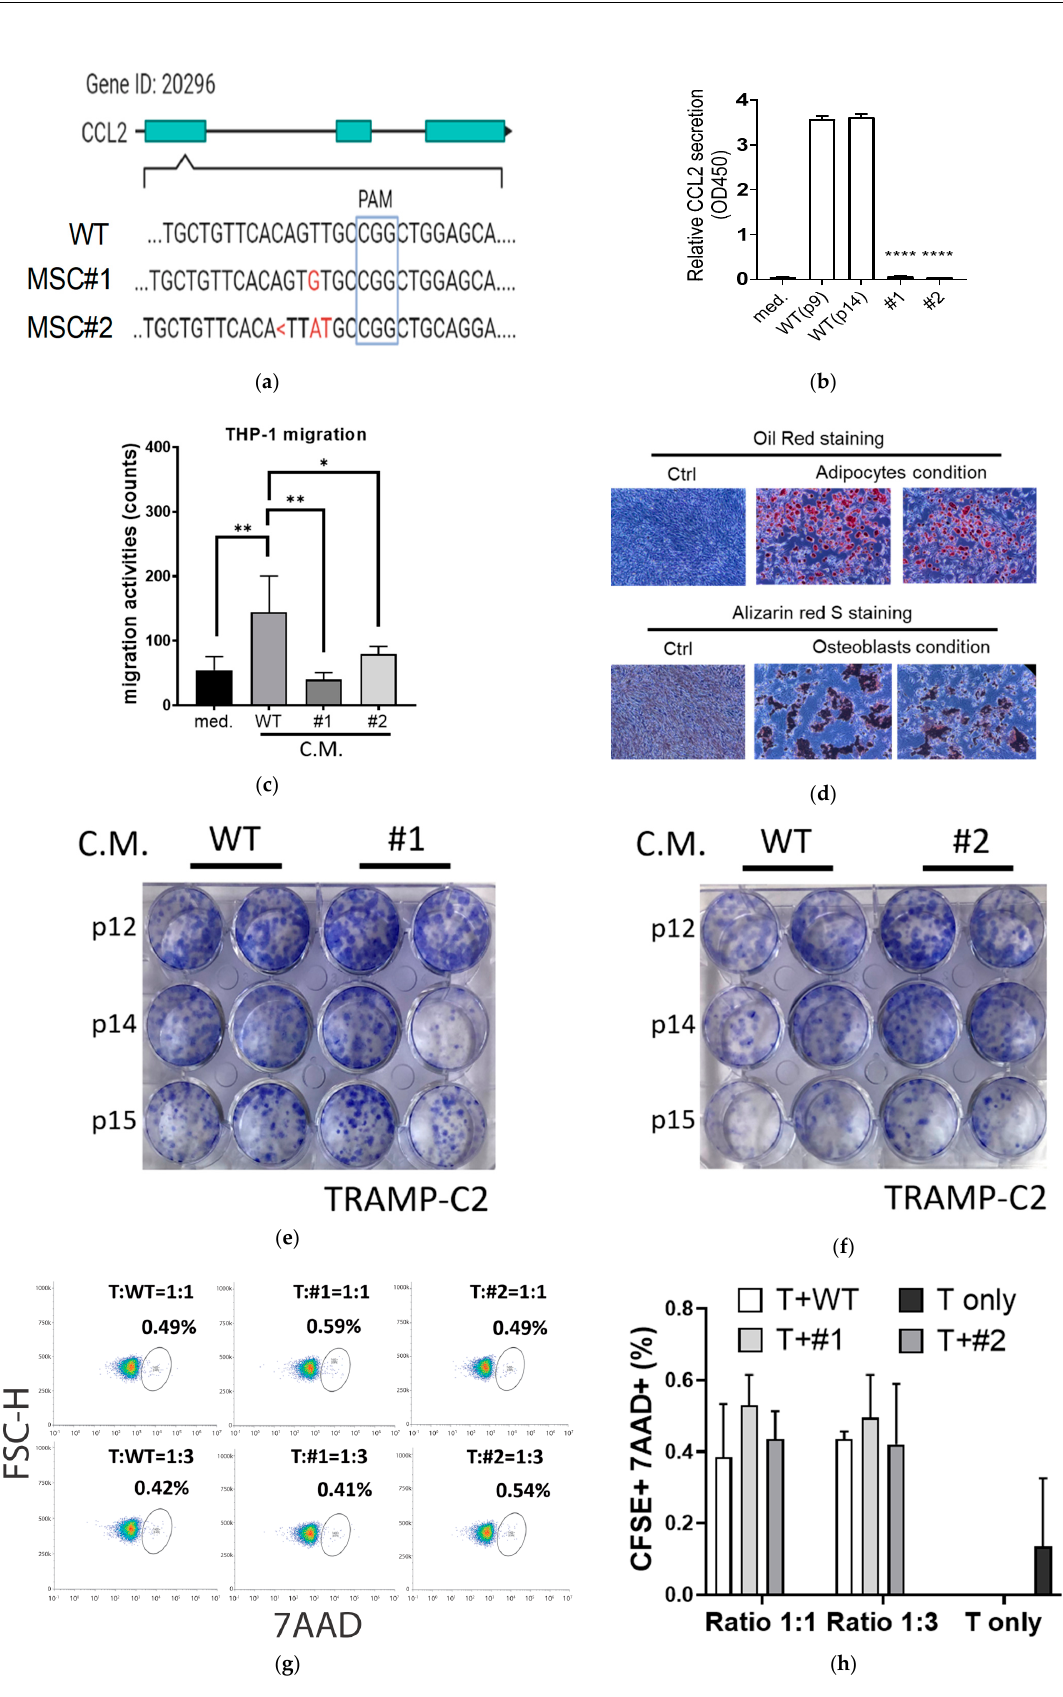
Figure 4. Lack of anti-proliferation function of MSCs in vitro. ( a ) Establishment of CCL2 knockout (KO) in bone marrow-derived MSCs. (WT vs. MSC#1-#2). PAM: the protospacer adjacent motif. <: deletion. Red: mutation. ( b ) Comparison of CCL2 protein secretion in cell media by ELISA. Different passage numbers of MSCs (p9 and p14) were compared with CCL2-KO MSCs (#1 and #2). med: negative control of the fresh medium. ( c ) Transwell analyses of THP-1 cells in response to different conditioned media (C.M.) collected from MSCs (WT vs. #1-#2). n = 3. ( d ) Differentiation of CCL2- KO MSCs to adipocytes (oil red) and osteoblasts (Alizarin red S). MSCs without differentiation treat- ment serve as control (Ctrl). ( e , f ) Colony-formation assays using C.M. collected from the MSCs [panel ( e ): WT vs. #1; panel ( f ): WT vs. #2]. C.M. collected from different passage numbers (p12, p14, p15) was applied to TRAMP-C2; n = 2. ( g ) Co-culture assay using TRAMP-C2 cells (T) labeled with CFSE and then mixed with different MSCs (WT, #1, #2). After 48 h, the mixture was stained with 7AAD, and the CFSE ⁺ 7AAD ⁺ population was analyzed by flow cytometry. ( h ) Quantification of CFSE ⁺ 7AAD ⁺ population in TRAMP-C2 (T) collected from panel ( g ); n = 3. Student’s t -test. * p < 0.05. ** p < 0.01. **** p < 0.0001. 3.5. Enhanced Anti-Tumor Effects of the CCL2 KO MSCs in a Syngeneic Prostate Cancer Model MSC-derived CCL2 is involved in the tumor-promoting functions of macrophages [16], and targeting CCL2 has been a therapeutic approach [21,22]. Although we did not observe the anti-proliferation effects of the CCL2 KO MSCs in vitro, we sought to examine their roles in the TME developed in an immune-competent syngeneic mouse prostate can- cer model. We analyzed the profiles of secreted cytokine and confirmed again the lack of CCL2 in CCL2 KO MSCs clones (#1-#2, Figure 5a). Using a TRAMP-C2 cell line (TRAMP- C2/Luc-eGFP), expressing a fusion protein containing both an enhanced green fluorescent